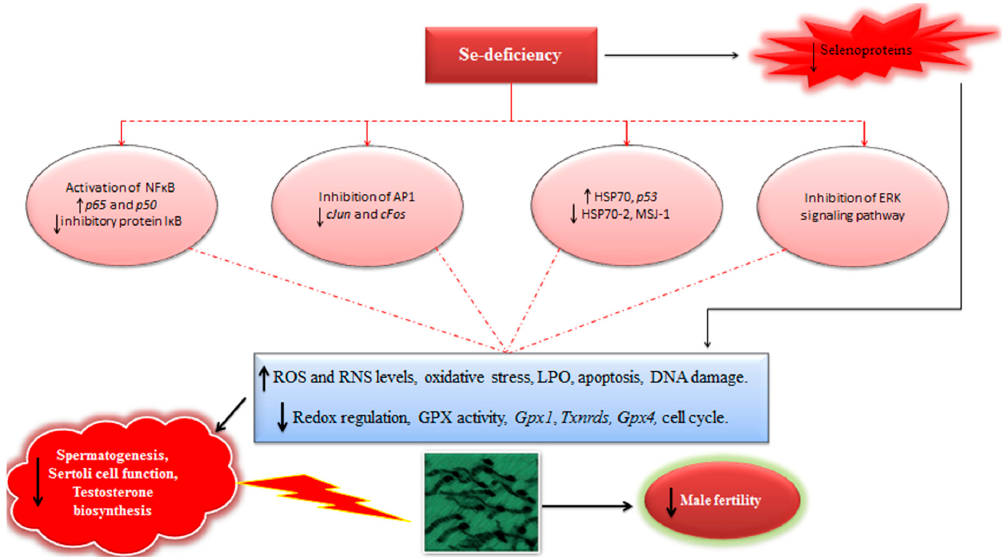
Figure 3. Schematic illustrating the implication of Se-deficiency in steroidogenesis, spermatogenesis, and male fertility (For details see the text in Section